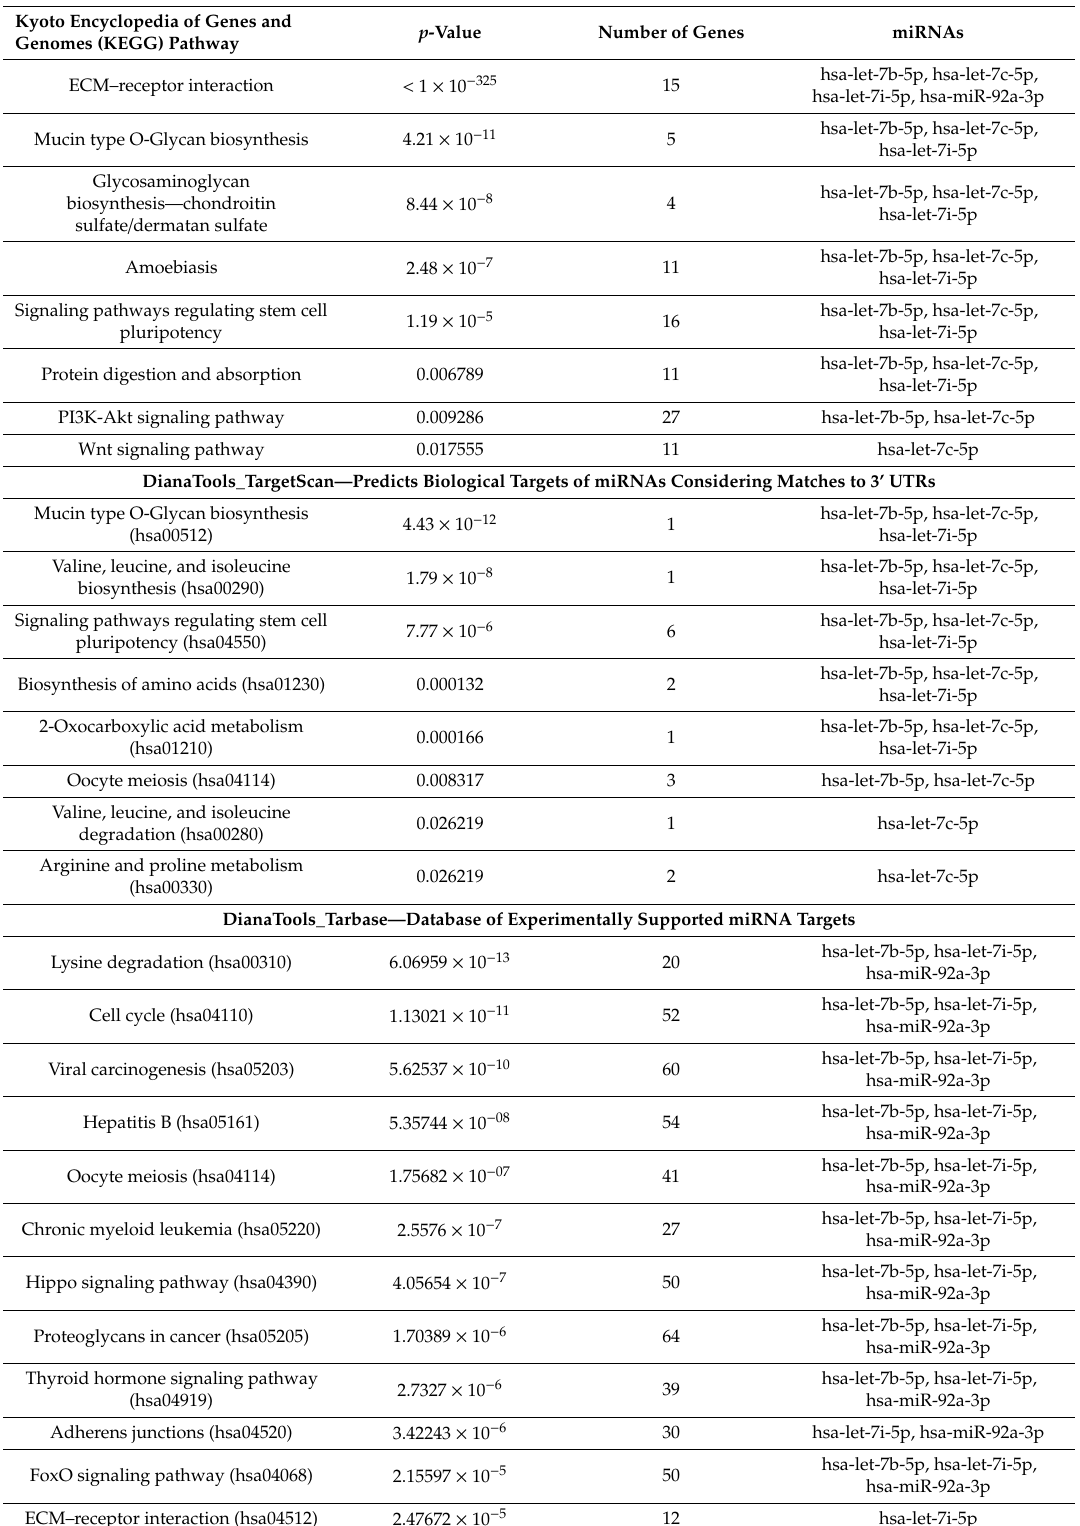
Table 4. Predicted and experimentally supported miRNA